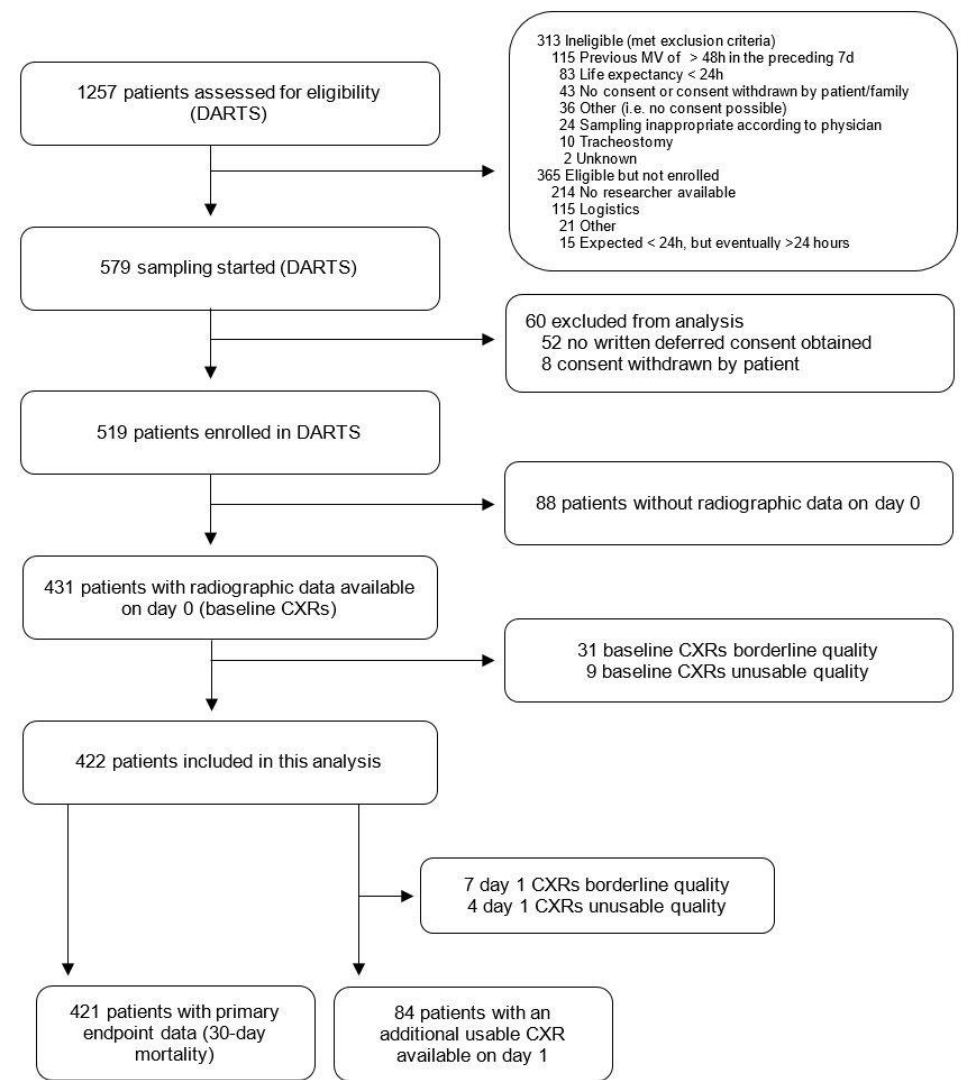
Figure 1. Flowchart of the inclusion process. DARTS = ‘ Diagnosis of Acute Respiratory Distress